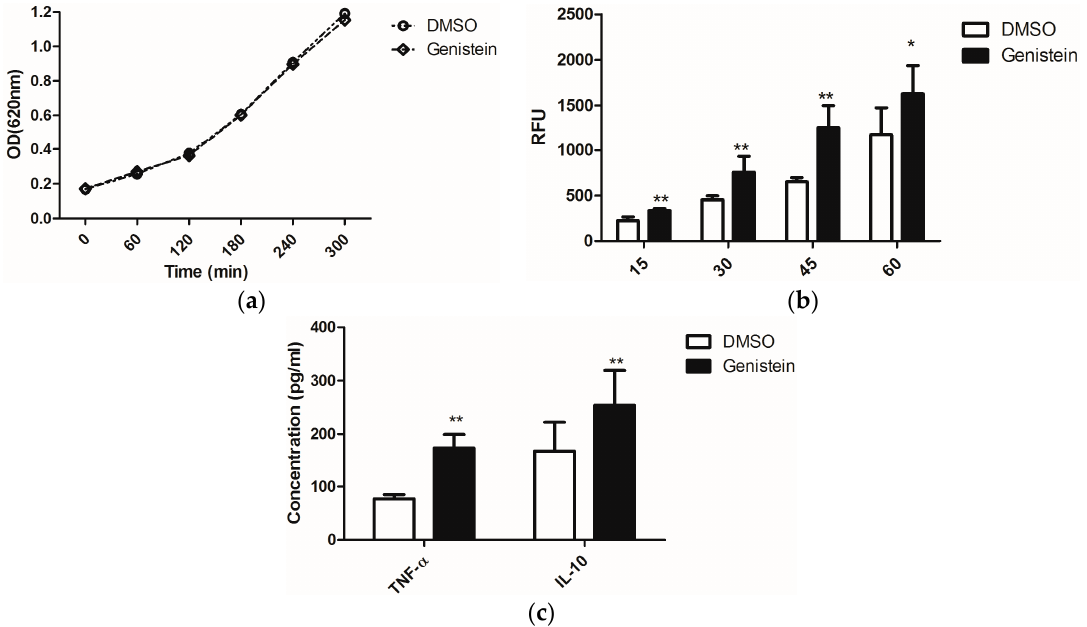
Figure 1. ( a ) Effects of genistein on growth of C. albicans . The optical density of the suspension was measured at 620 nm each hour using a μ Quant microtiter plate reader; ( b ) Phagocytosis of genistein treated C. albicans by the murine macrophage cell line RAW 264.7. RFU: relative fluorescence units. ** p < 0.01, * p < 0.05; ( c ) Release of TNF- α and IL-10 by macrophages, which were incubated with genistein treated C. albicans ; ** p < 0.01 (comparison with DMSO control).